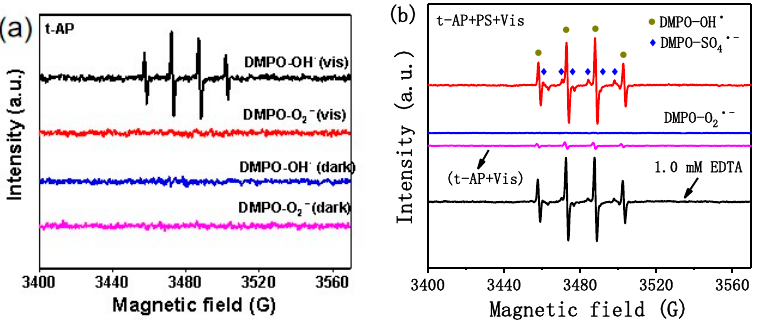
Figure 10. ( a ) DMPO spin trapping EPR spectra with Ag 3 PO 4 as catalyst in aqueous dispersion for